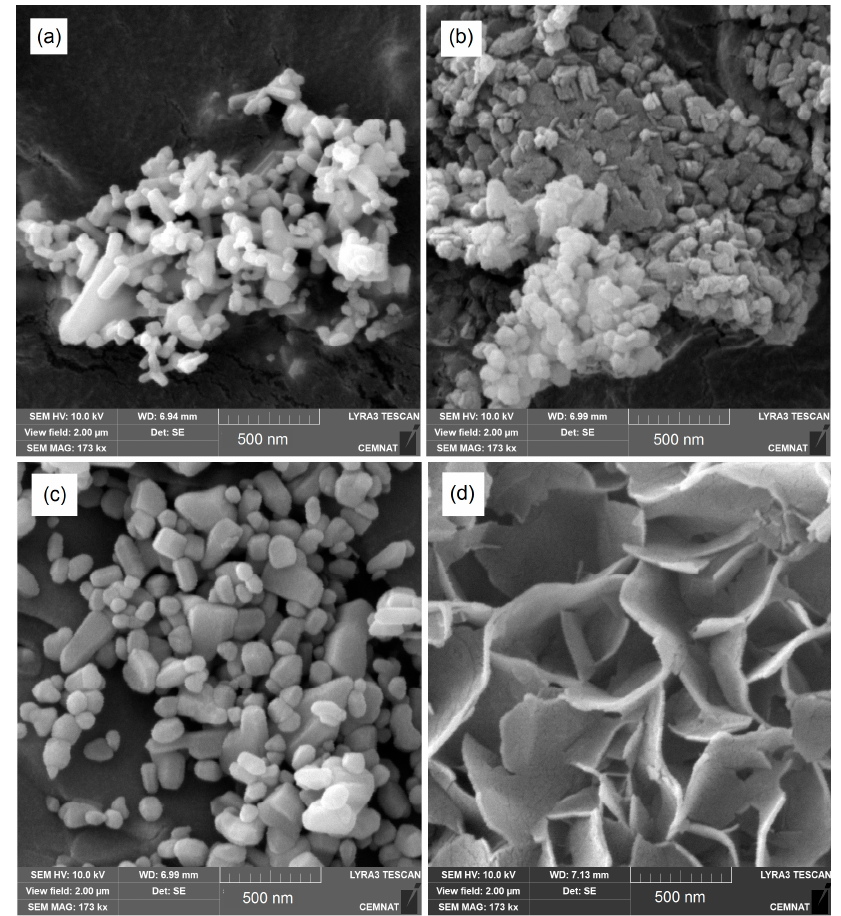
Figure 2. SEM photographs of inorganic nanoparticles: ( a ) originally supplied ZnO; ( b ) originally supplied MgO; ( c ) ZnO affected by polymerization conditions; ( d ) MgO affected by polymerization conditions.